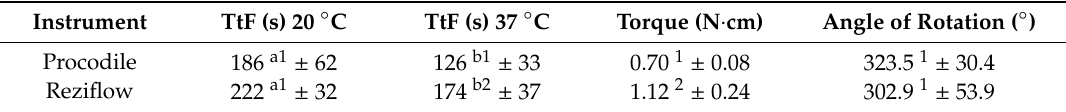
Table 1. Mean ± standard deviation of the time to fracture (TtF), torque (N · cm), and angle of rotation ( ◦ ) of the tested